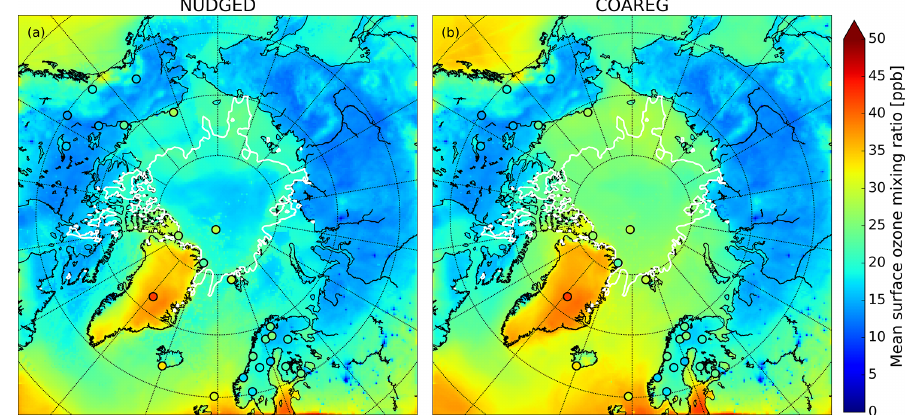
Figure 3. Spatial distribution of the simulated mean surface O 3 mixing ratio (ppb) for the (a) NUDGED and (b) COAREG runs. The filled circles indicate the mean observed ozone mixing ratios (ppb) for the simulated period. To indicate the sea ice extent, the white contours show the sea ice fraction of 0.5 at the start of the